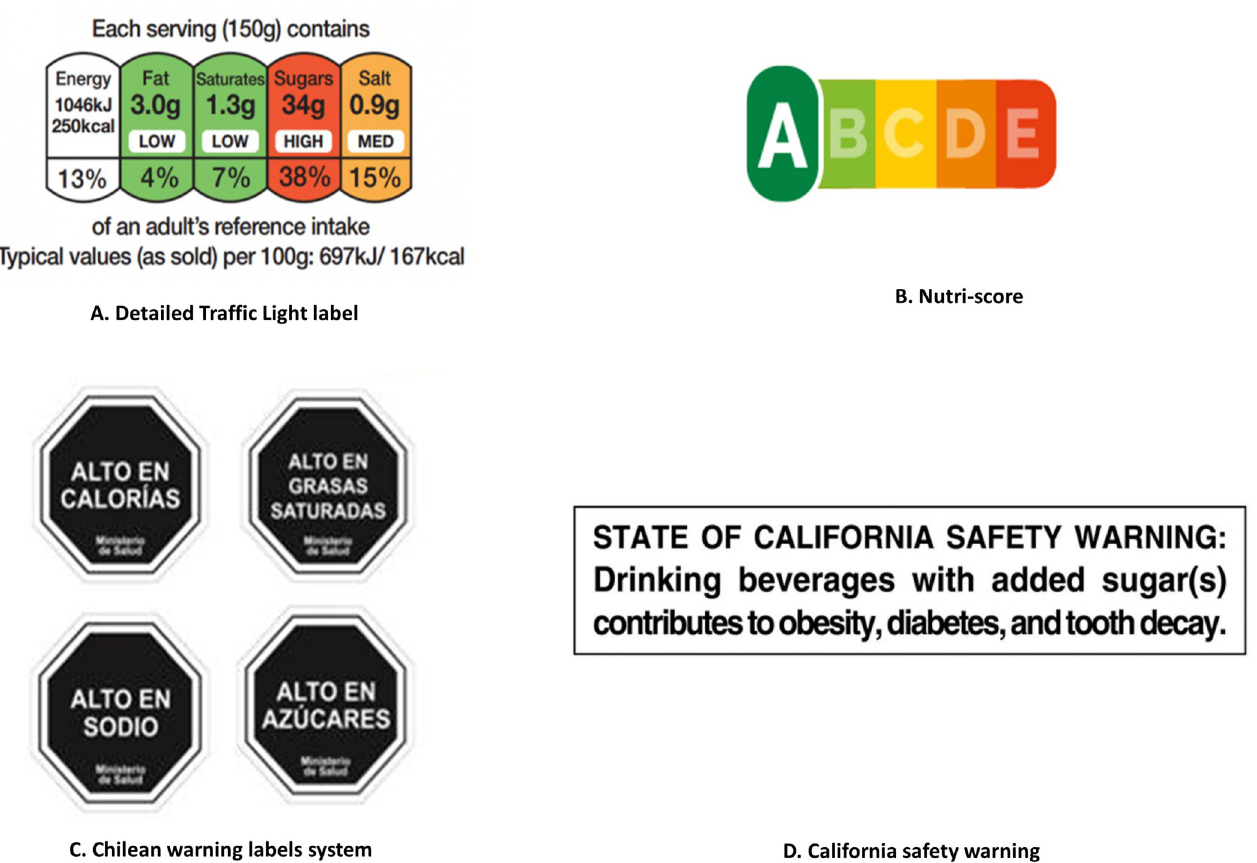
Fig 3. The design of colour-coded labels (A, B) and warning labels (C, D). (A) UK traffic light label uses green, amber, and red to represent low, moderate, and high levels of fat, saturated fat, sugar, and sodium per 100 g or per 100 ml on the front of food packages, respectively, with addition of the % reference intake value for calorie and each nutrient. (B) NS includes a colour spectrum ranging from dark green to dark orange with letters from A to E. Products assigned an “A” were considered to have the best nutritional quality while “E” the poorest. (C) Chilean warning labels is a type of NW with a textual warning “high in [calorie/nutrient]” presented on the octagonal signs in a black-and-white design. (D) California safety warning is a type of HWs designed for sugar-sweetened beverages with � 75 calories contributed by added sugar. HW, health warning; NS, Nutri-Score; NW, nutrient warning.